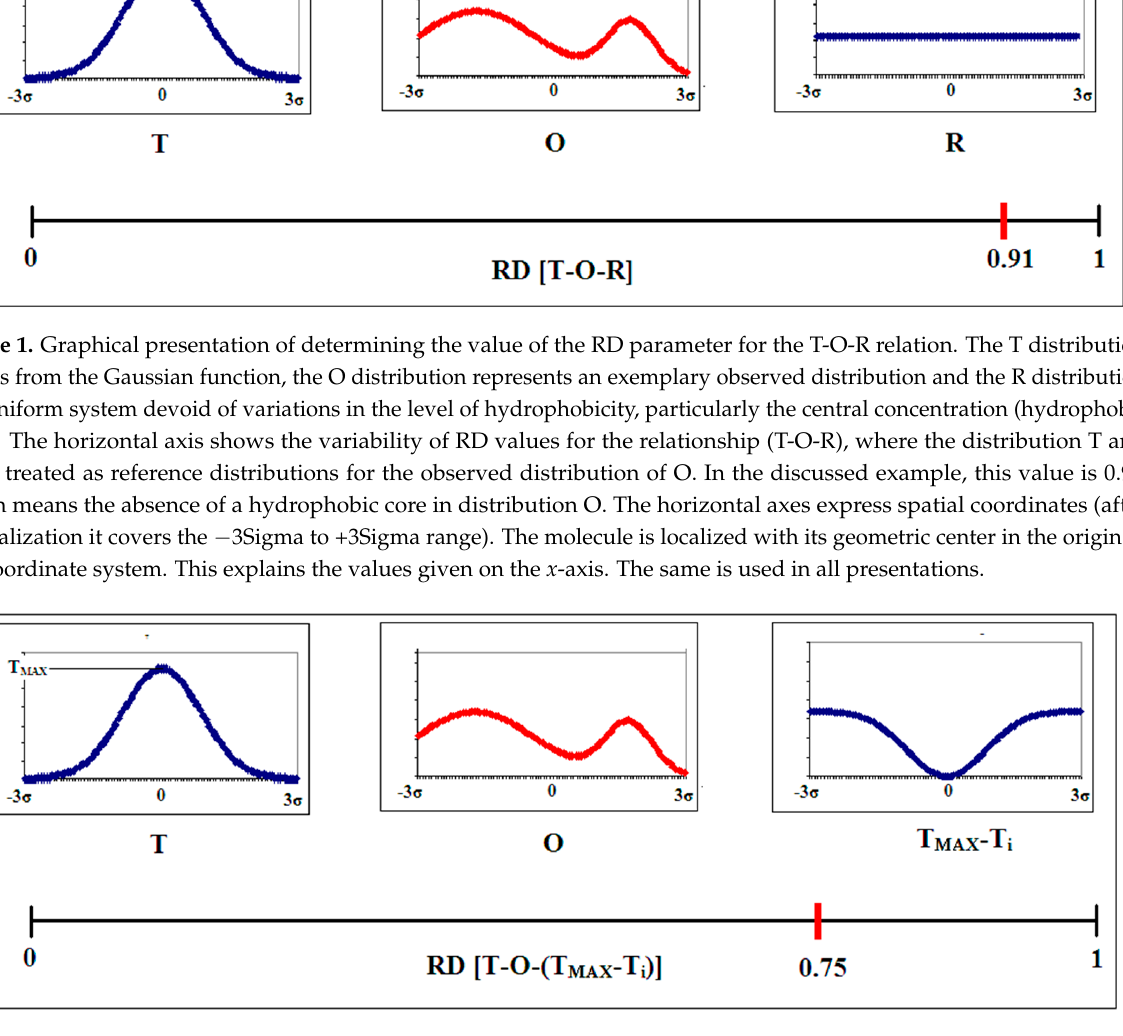
Figure 1. Graphical presentation of determining the value of the RD parameter for the T-O-R rela- tion. The T distribution results from the Gaussian function, the O distribution represents an exem- plary observed distribution and the R distribution is a uniform system devoid of variations in the level of hydrophobicity, particularly the central concentration (hydrophobic core). The horizontal axis shows the variability of RD values for the relationship (T-O-R), where the distribution T and R are treated as reference distributions for the observed distribution of O. In the discussed example, this value is 0.91, which means the absence of a hydrophobic core in distribution O. The horizontal axes express spatial coordinates (after normalization it covers the − 3Sigma to +3Sigma range). The molecule is localized with its geometric center in the origin of the coordinate system. This explains the values given on the x -axis. The same is used in all presentations.